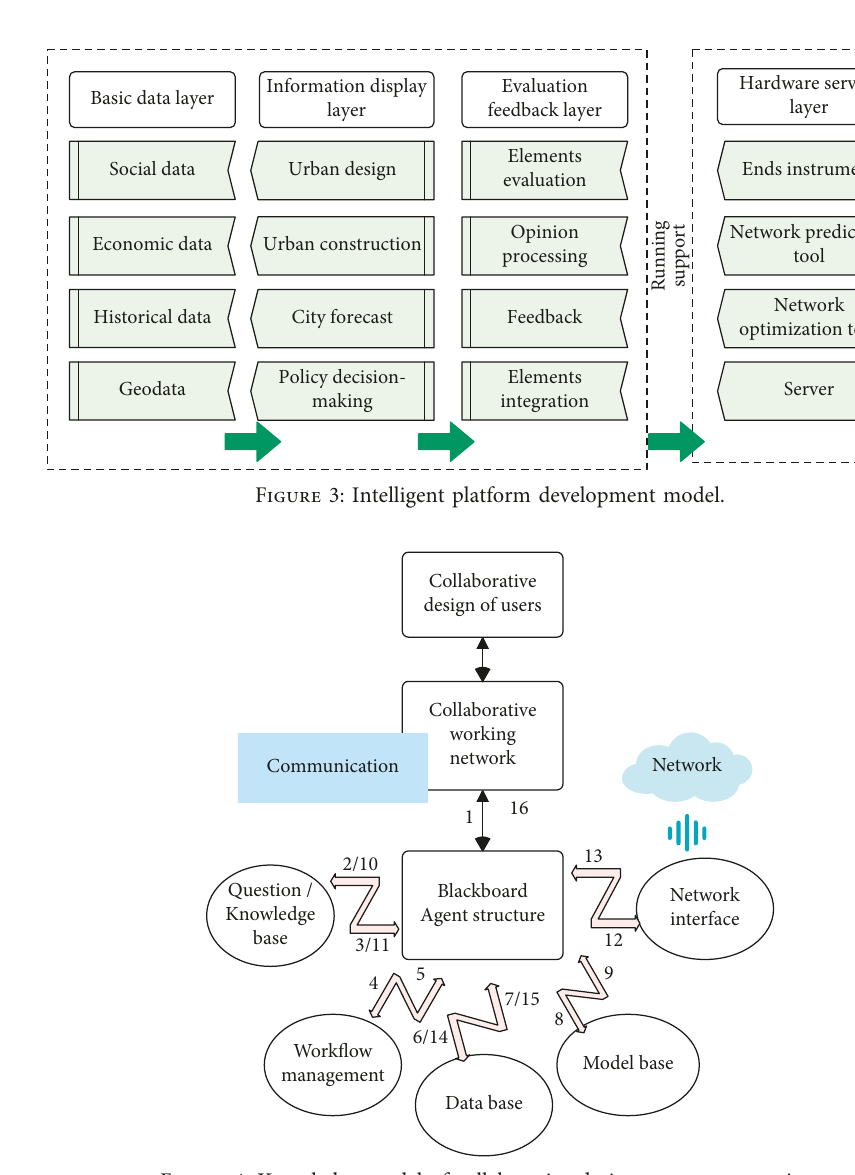
Figure 4: Knowledge model of collaborative design process